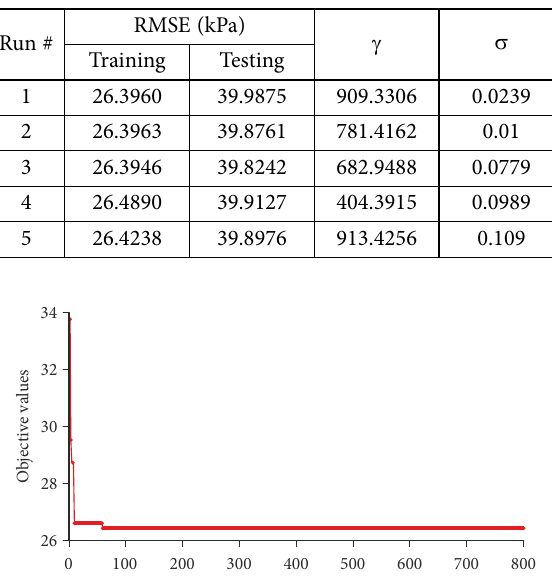
Table 3. Training and testing performance of 5 runs